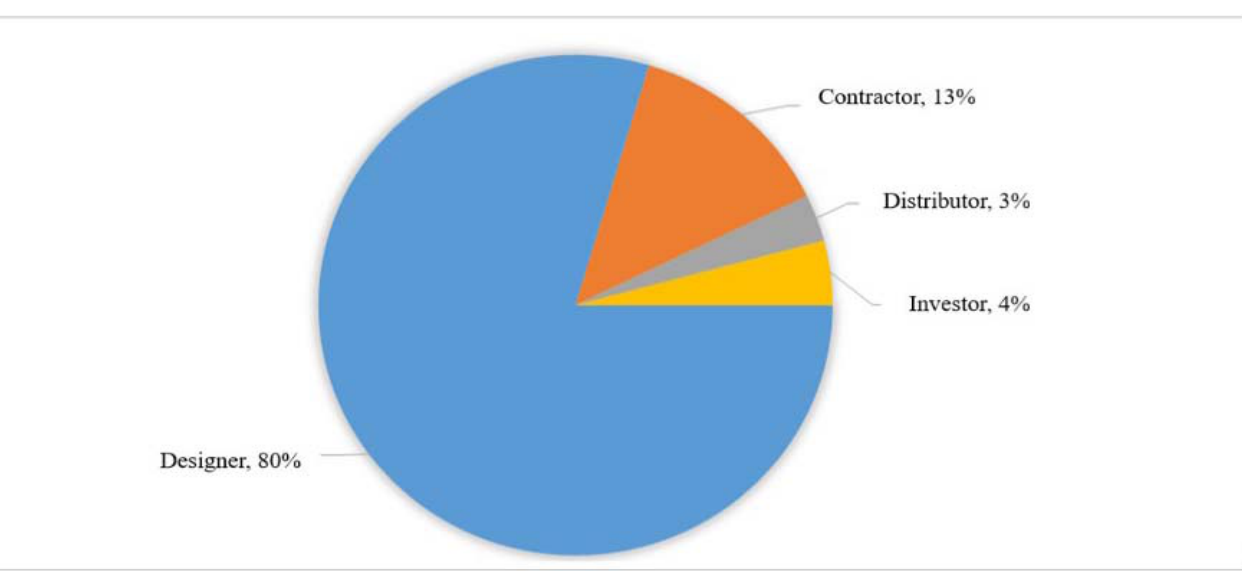
Source: Developed by the